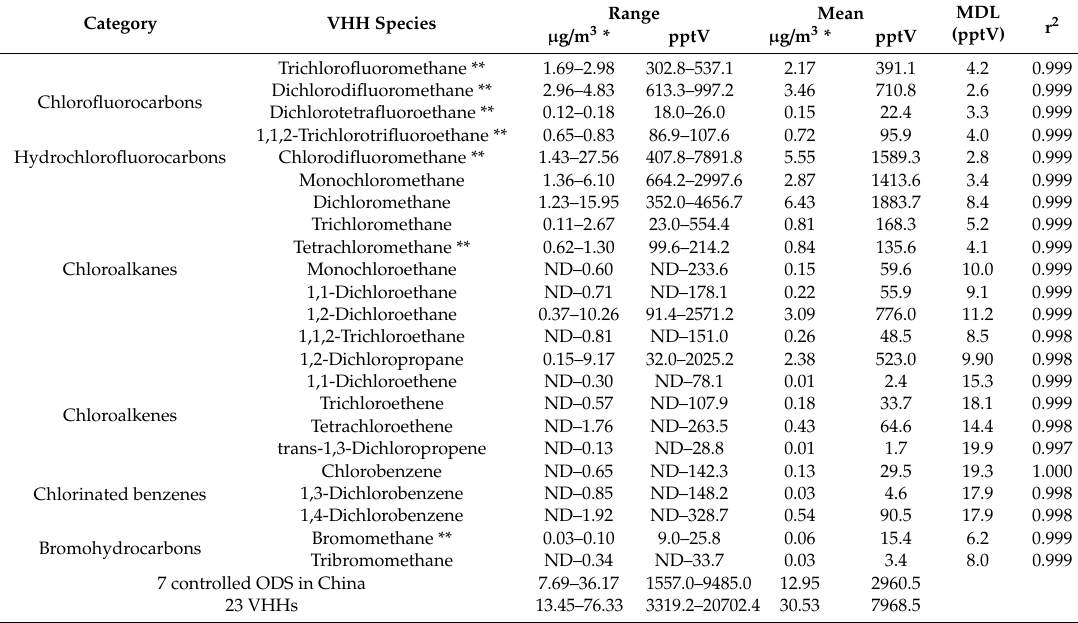
Table 1. Mass concentrations of 23 volatile halogenated hydrocarbons (VHHs) at the study site. Category VHH Species Range